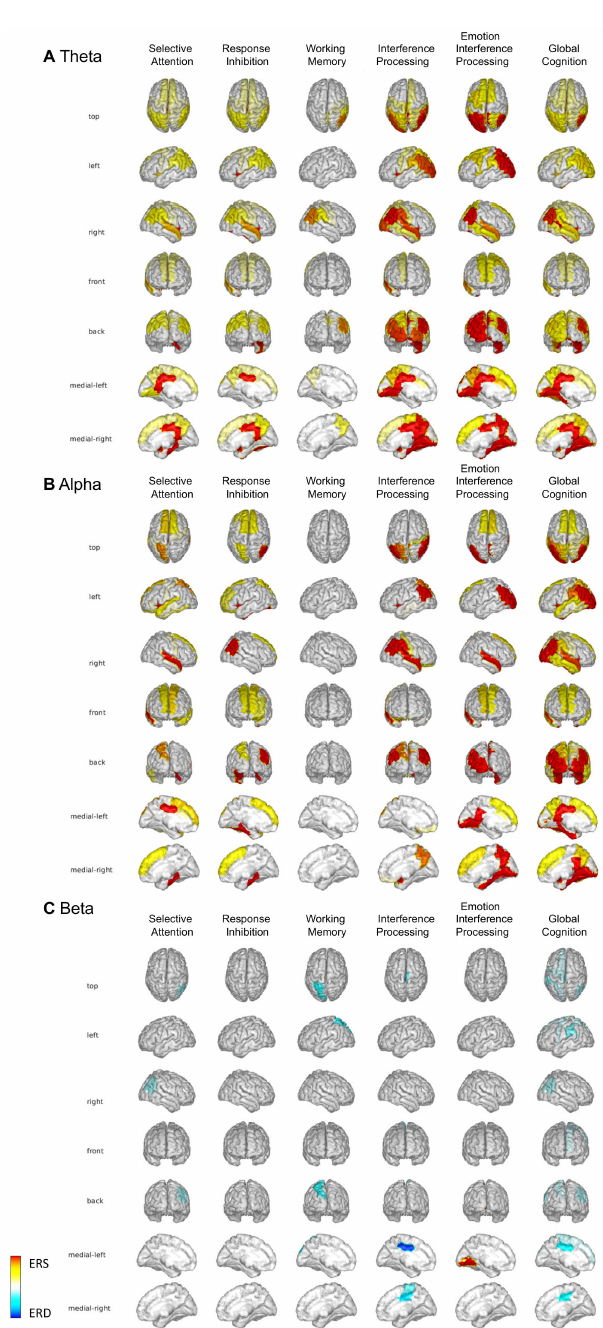
Figure A3. The figure shows the statistically corrected source-localization results from Balasubramani et al., (2021). The heatmap colors represent Bonferroni-corrected significant theta and alpha band event-related synchronization (ERS) and beta band event-related desynchronization (ERD) during stimulus encoding relative to baseline for each of the five cognitive tasks, and for the global cognitive task average. This source-localized data were used for our present